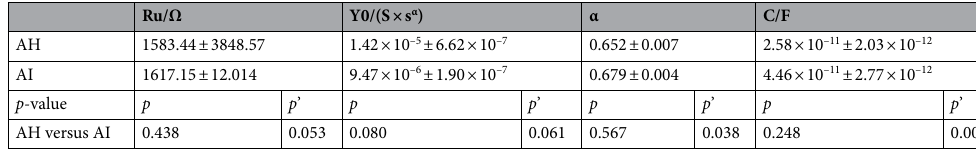
Table 3. List of all the components extracted from the equivalent circuit model shown in Fig. 3 and two- tailed p -value using paired t-test, including the electrolyte resistance (Ru), the admittance (Y0), the exponent (α) of the constant phase element (CPE), and the parasitic capacitance (C). Evaluations are made both with outliers (6 electrodes) and without outliers (4 electrodes). AH after hydrogel coating, AI after implantation. p -values from two-tailed paired t-test were included here. p : p -value of all data; p ’: p -value of data with outliers